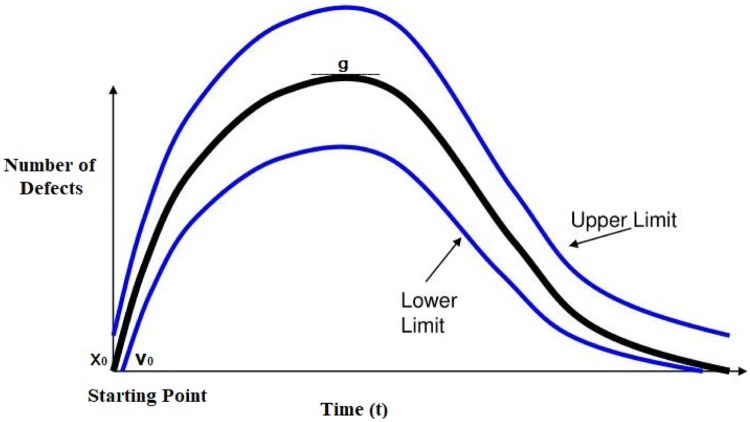
Rayleigh distribution curve [40].